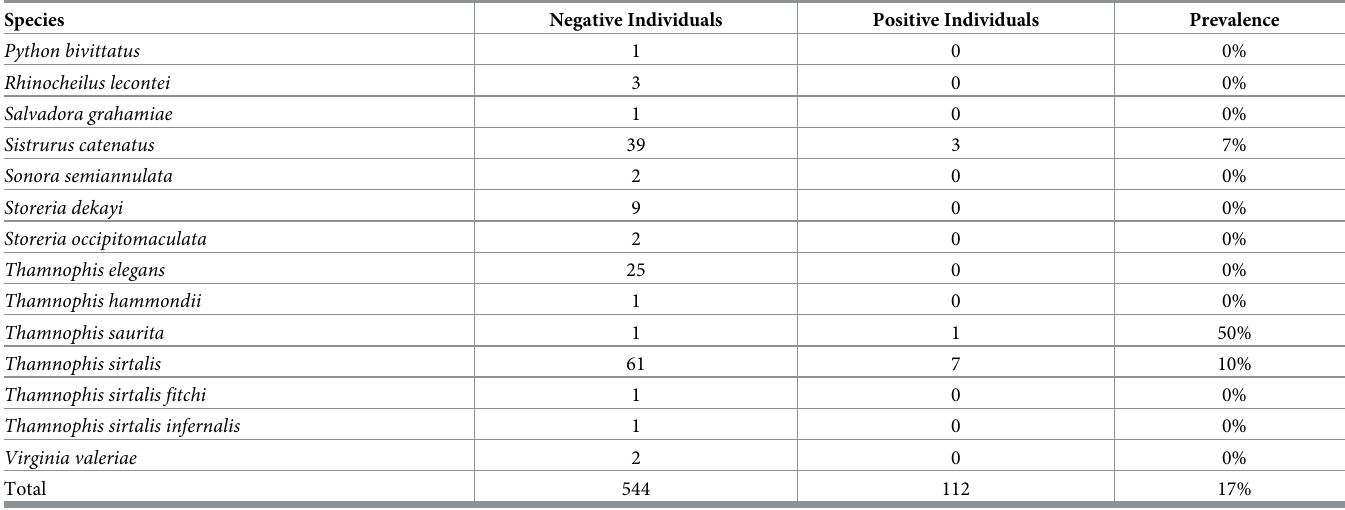
for ophidiomycosis status (four output categories). The final data set for the model included 595 individuals representing 394 adults, 101 juveniles, and 100 snakes of unknown age. There were 419 negative, 55 Ophidiomyces present, 78 possible ophidiomycosis, and 43 apparent ophidiomycosis individuals. The final model explained 96% of the variance (AICc: 637.56, AICc weight: 0.96) with the following variables: state (p < 0.0001) and age (p = 0.003). The sig- nificant positive predictors of apparent ophidiomycosis included the states Georgia (OR: 5.28, 95% CI: 1.31–21.51, p = 0.027), Massachusetts (OR: 6.0, 95% CI: 1.26–28.55, p = 0.041), and Pennsylvania (OR: 8.75, 95% CI: 1.76–43.6, p = 0.009). Juveniles were 2.38 (95% CI: 1.39–4.17, p = 0.002) times less likely to have ophidiomycosis than